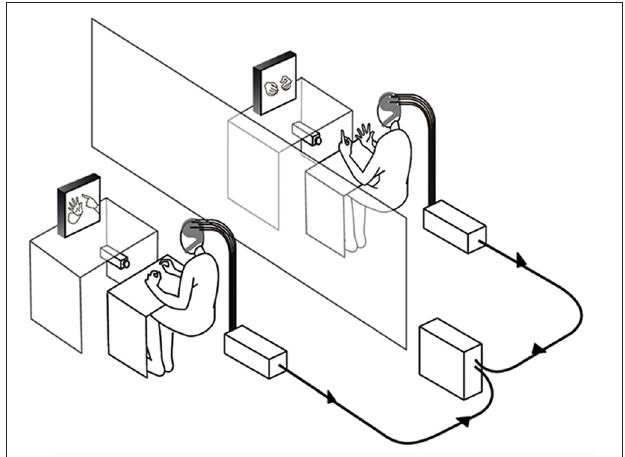
FIGURE 1 | Apparatus and experimental setting of the double-video system and dual-EEG recording.